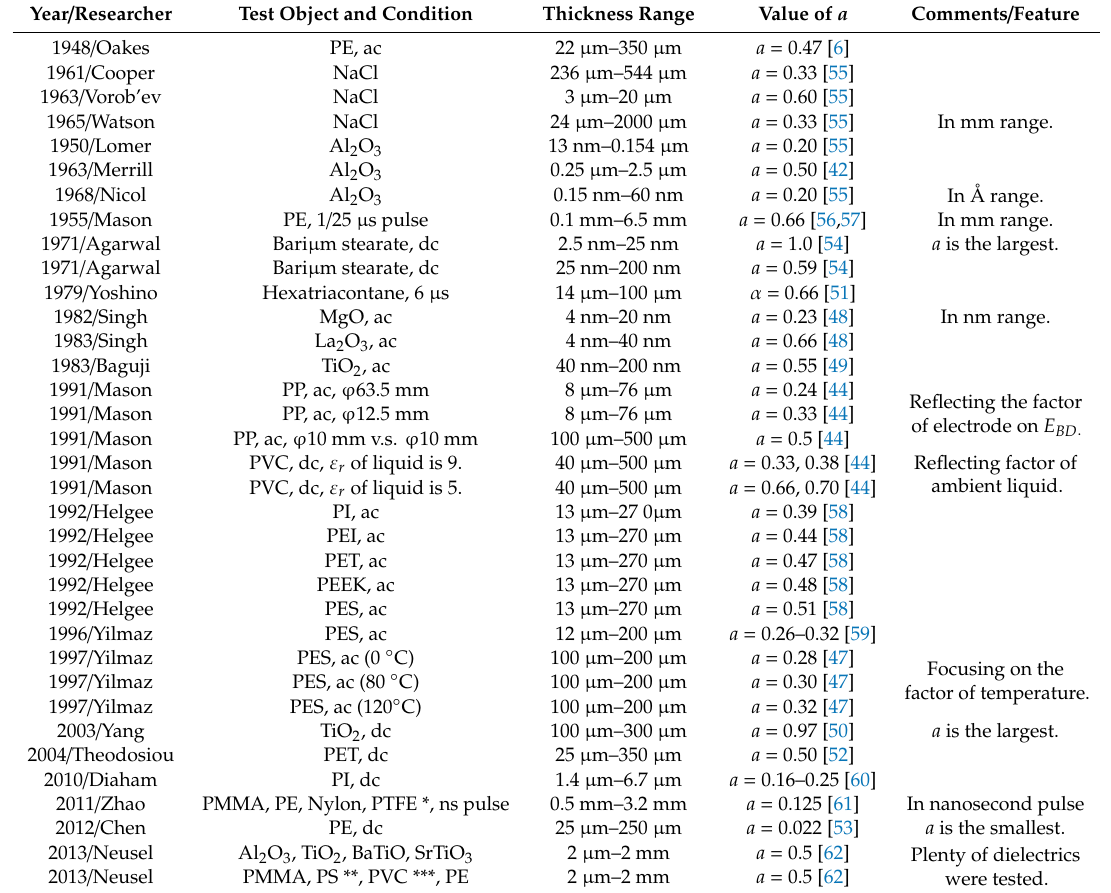
Table 3. Summary of the experimental results for the relation of E BD = E 1 d - a for the thickness e ff ect.